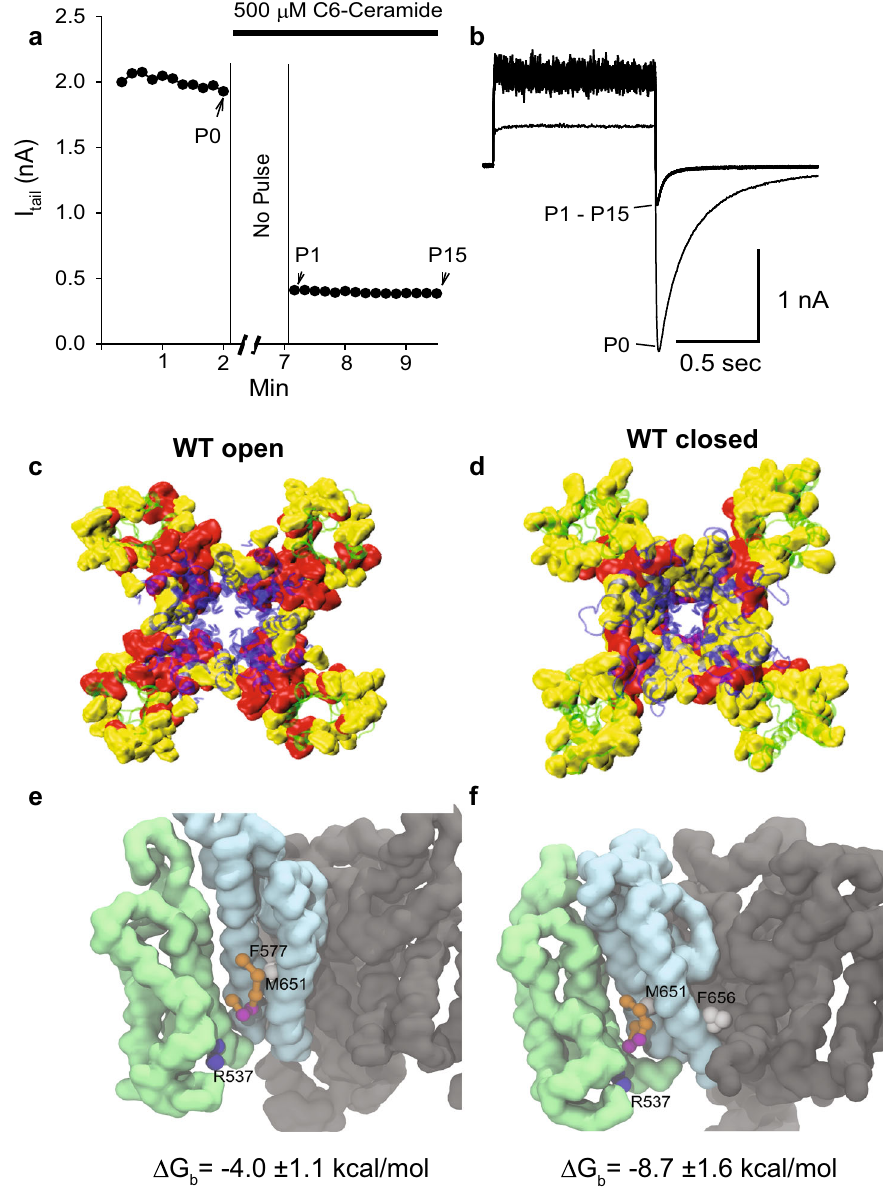
Fig. 2 Ceramides induce apparent closed-channel block. a Tonic block experiments on cardiomyocytes cell-line. The time course of the change of I hERG1A tail currents were recorded by a train of test pulses. After recorded baseline control currents (P0), 500 µ M C 6 -ceramide was added and the membrane potential was held at − 80 mV with no test pulse given for 5 min. Then, the test pulses (P1-P15) were reapplied and channel currents were recorded in the presence of ceramide. b Superimposed current traces of P0 and P1-P15. Similar results were found in all 5 tested cells. Raw data are provided in Source Data — Fig. 2a, b. Panels c and d show the contact mapping for ceramides (extracellular view) from CG-MD simulations for hERG1A-WT open- ( n = 4) and closed- ( n = 3) PD states, respectively. The voltage-sensor and pore-domains (VSD and PD) are shown as green and blue cartoons, respectively. The residues identi fi ed using the maximum-occupancy criteria are shown in a red surface representation. The residues identi fi ed through contact-duration but not through maximum-occupancy metrics are highlighted as a yellow surface. A color-coded list of residues is provided in Source Data — Fig. 2c, d. For each system, the contact-duration and maximum-occupancy metrics were calculated considering the tetrameric structure of the channel, totalling 4 × n replicas per-residue (see Source Data for Supplementary Figs. 5 and 6). The last 8 microseconds of each replica were used for analysis. Panels e and f show an illustrative snapshot for the binding of CER6 at the VSD – PD interface (light green and blue molecular surfaces, respectively) of the open- and closed-PD states, respectively. Only one of four VSD – PD interfaces is shown for clarity. The other subunits are shown in dark-gray color. The residues R537, F557, M651, and F656 are shown for perspective only, represented as spheres and colored according to polarity (blue: polar( + ), white: apolar). The ceramide molecule is shown in balls and sticks representation and colored based on bead polarity (purple: polar headgroup, orange: apolar tails). The binding-free energy calculated with FEP approach are shown (Source Data — Supplementary Fig. 2e,